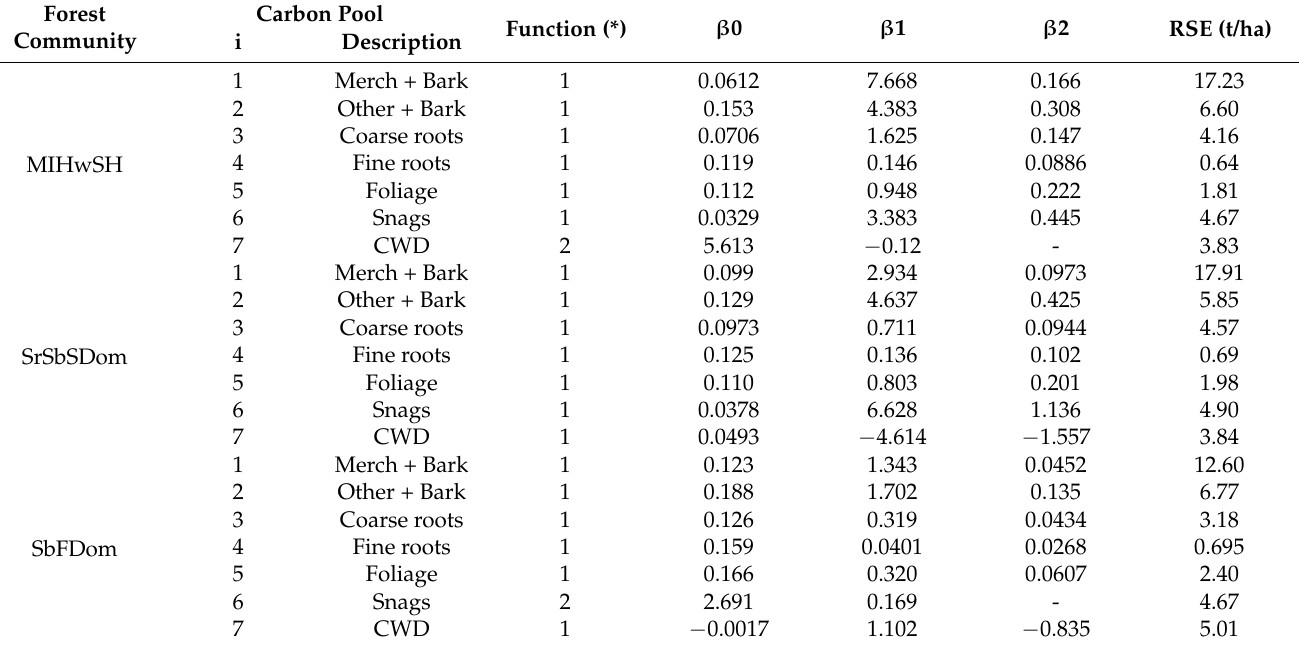
Table 3. Coefficients and residual standard errors (RSE) for the logistic function relating the mer- chantable volume with age for each forest community ( n = 4018).